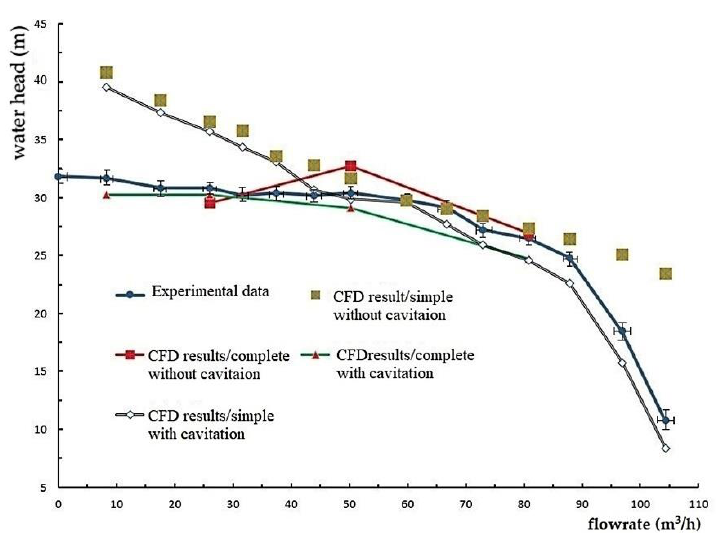
Figure 6. Comparison curve between simulation results and experimental results of the present blade disc pump.